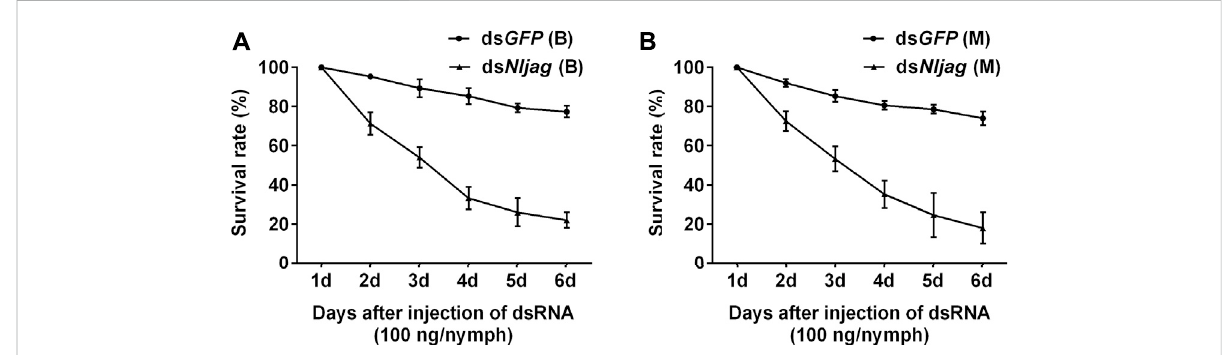
FIGURE 8 Survival rates of BPH developed from nymphs treated with ds Nljagged . (A) : Survival rate of 100 ng ds Nljagged injection of the Brachypterous strain. (B) :Survivalrateof100 ngds Nljagged injectionoftheMacropterousstrain.Third-instarnymphsontheseconddayafterecdysiswereinjected with dsRNA. Equivalent ds GFP was used as a control. Each value is a mean of three replicates, with 50 nymphs per replicate. Data represent the mean ± standard error ( n = 3).